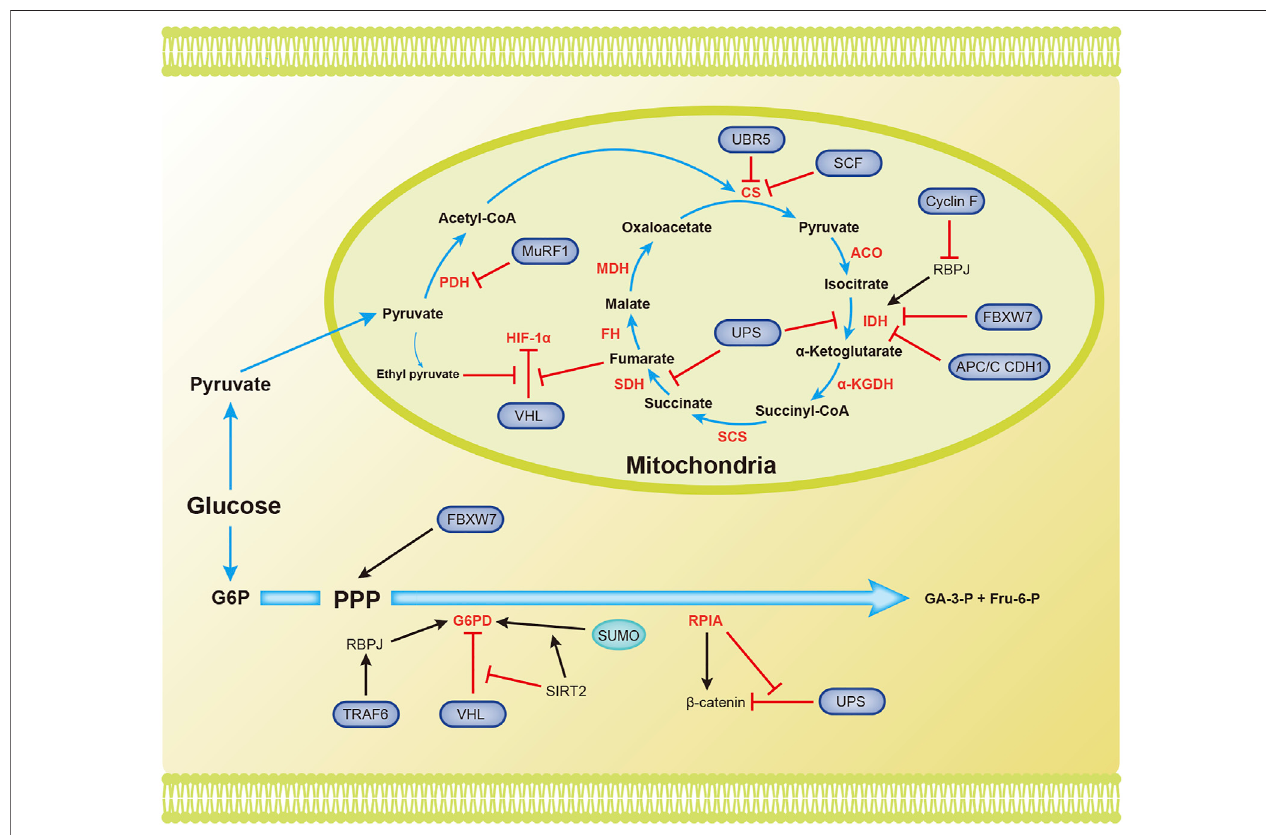
FIGURE 3 | Overview of the mechanisms by which ubiquitination and SUMOylation regulate the TCA cycle and PPP. The blue arrow represents the fl ow of metabolites. The black and red arrows represent activation and inhibition, respectively. ACO, aconitase; CS, citrate synthase; FBW7, F-box and WD repeat domain- containing protein 7; FH, fumarate hydratase; Fru-6-P, fructose 6-phosphate; G6PD, glucose-6-phosphate dehydrogenase; GA-3-P, glyceraldehyde 3-phosphate; IDH, isocitrate dehydrogenase; MDH, malate dehydrogenase; PDH, pyruvate dehydrogenase; RPIA, ribose-5-phosphate isomerase A; SCF, Skp1-Cul1-F-box protein; SCS, succinyl-CoA synthetase; SDH, succinate dehydrogenase (Complex II); SIRT2, silent information regulator 2; SM22 α , smooth muscle (SM) 22 α protein; UPS, ubiquitin proteasome system; α -KGDH, α -ketoglutarate dehydrogenase.